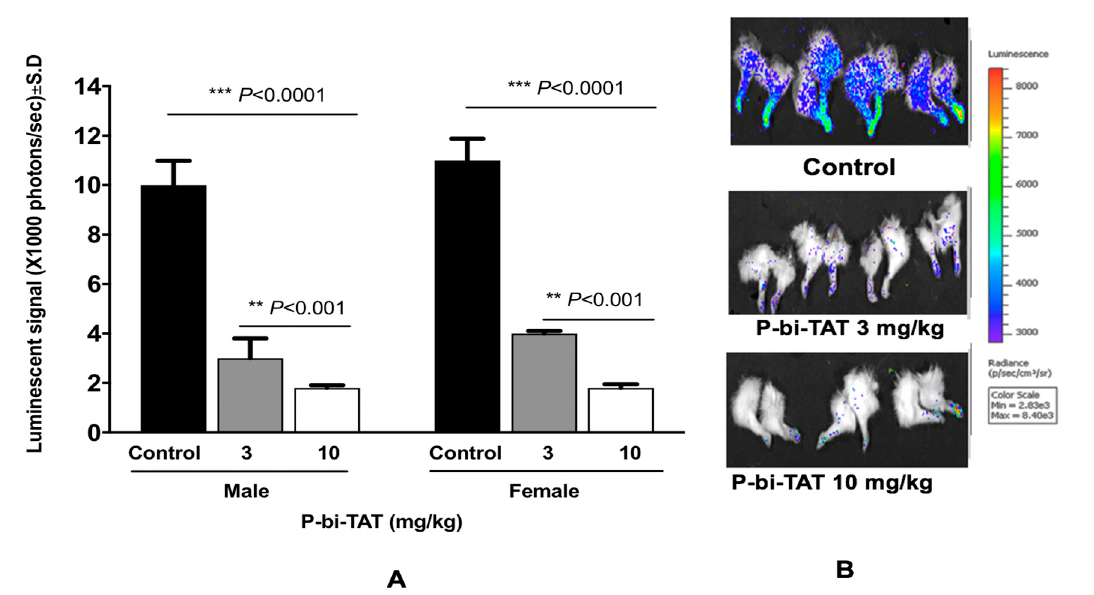
Figure 3. P-bi-TAT effect on bone marrow metastasis in AML mice as evaluated with In Vivo Imaging System (IVIS). ( A ) High luminescent signal intensity was observed in the control group of mice in comparison to the treated groups. No differences in signal intensity could be detected between males and females. ( B ) Bioluminescent signals of THP1-lucia cells following termination in mouse bone marrow (showing hind legs). Results showed a successful decrease of engraftment of the leukemic cells in the group treated with P-bi-TAT (10 mg/kg). The color bar shows the relative color for signal intensity, ranging from nonviable ( blue ) to fully viable ( red ). (*** p < 0.0001, ** p < 0.001). Results are expressed as mean ± S.D., n = 4–5 mice/group.